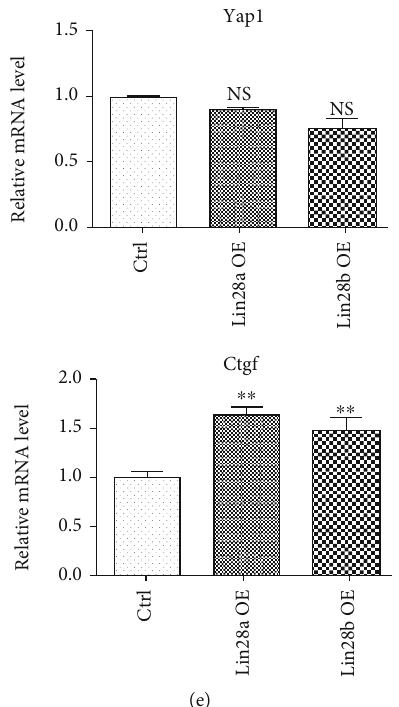
Figure 1: Constitutive expression of Lin28a/b in mouse ESC induced Yap1 expression and reduced lineage-speci fi c gene expression. (a) Phase-contrast microscopy and AP staining of Ctrl and Lin28a/b constitutively expressed (Lin28a/b OE) mouse ESCs grown under 2i +LIF medium. Scale bar, 200 μ m. (b) Western blot analyses of total proteins from Ctrl and Lin28a/b OE mouse ESCs using the indicated antibodies. Oct4, Sox2, and Nanog are pluripotent stem cell markers. (c) Quantitative real-time PCR to examine the mRNA level of lineage-speci fi c gene expression in Ctrl and Lin28a/b OE mouse ESCs, trophectoderm gene Cdx2 , ectoderm gene Nestin , mesoderm gene T , and endoderm gene Gata6 . Actin was analyzed as an internal control. The data are shown as the mean ± S : D ( n = 3 ). Statistically signi fi cant di ff erences were indicated ( ∗ , P < 0 : 05 and ∗∗ , P < 0 : 01 ). (d) Western blot analyses of total proteins from Ctrl and Lin28a/b OE mouse ESCs using the indicated antibodies. (e) Quantitative real-time PCR to examine the mRNA level of Yap1 and its downstream target gene Ctgf expression in Ctrl and Lin28a/b OE mouse ESCs. The data are shown as the mean ± S : D ( n = 3